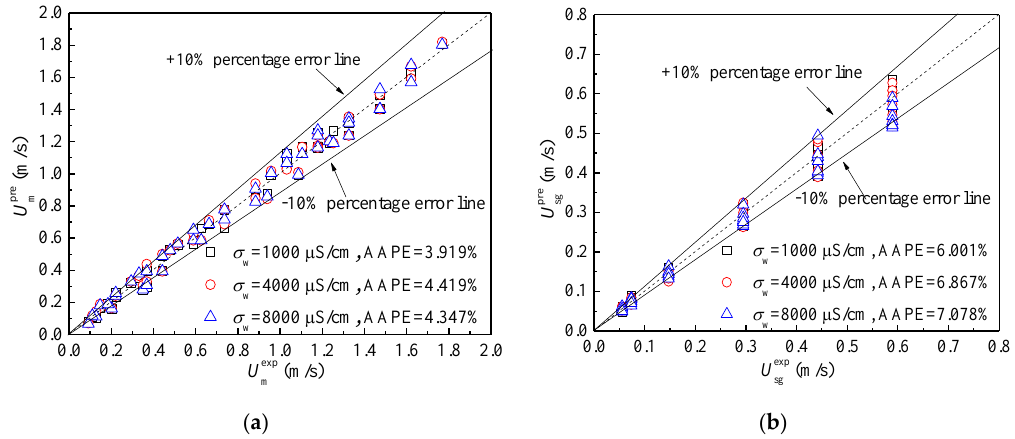
Figure 14. Salinity independent flow velocity measurement: ( a ) Mixture velocity; ( b ) Gas phase superficial velocity.